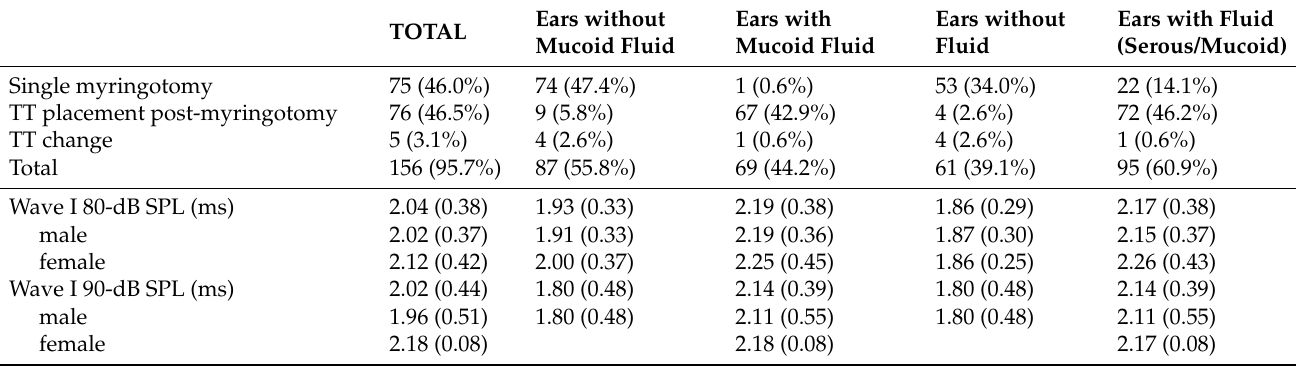
Table 2. Summary of effusion type, operative procedure, and intraoperative ABR findings (latencies in mean and standard deviation).